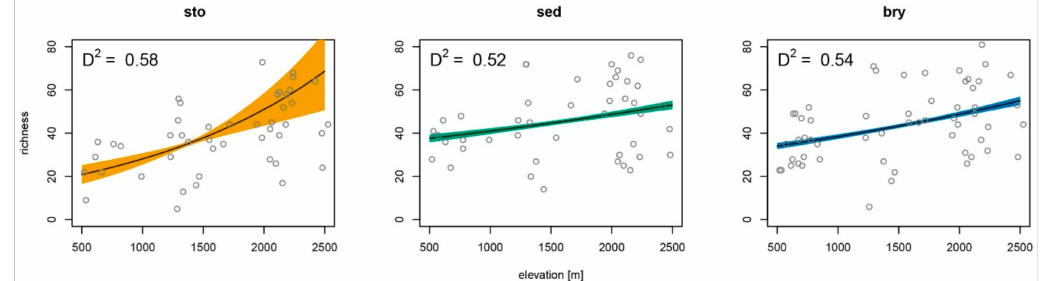
Figure 4. Species richness of diatoms on di ff erent microhabitats along an elevational gradient according to the models presented in Table 1. Microhabitats: sto = stones, sed = sediment, bry = bryophytes. Habitat diversity (Z = 4.953, p < 0.001) was the strongest explanatory factor of species richness